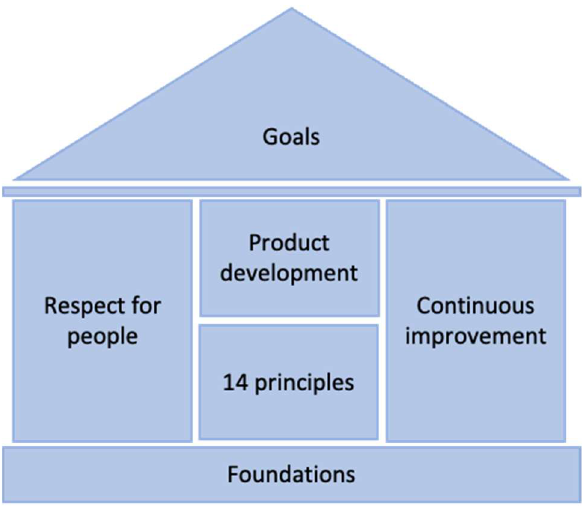
Figure 4. Lean Thinking house.